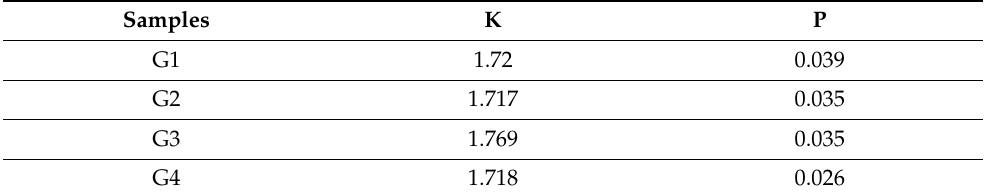
Table 1. The K and P of four sediment samples in four working conditions.